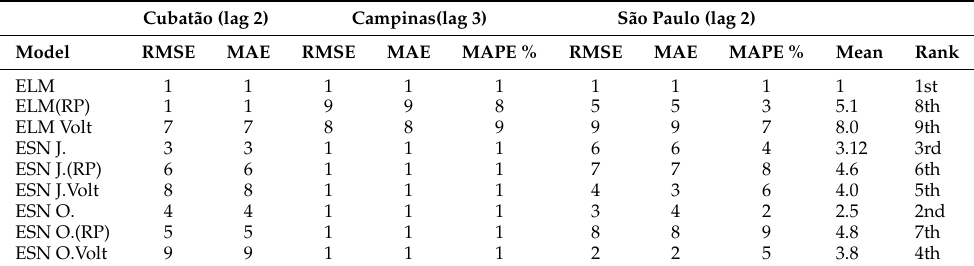
Table 6. Ranking of the models’